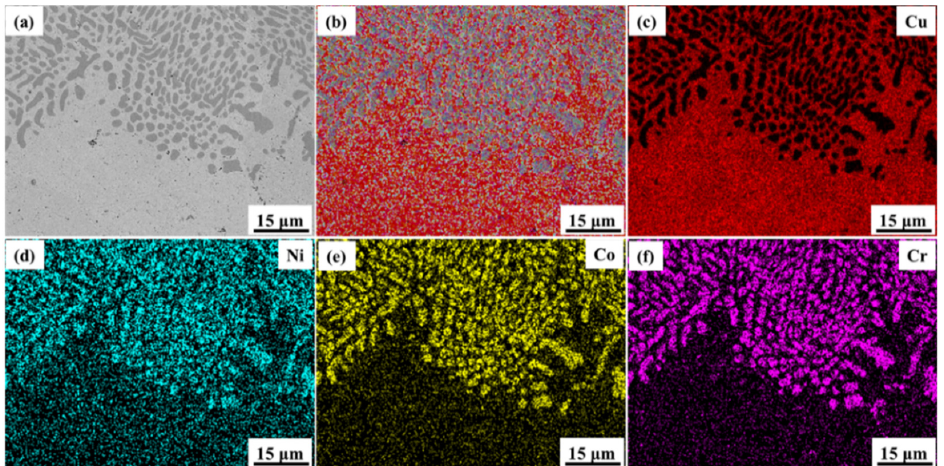
Figure 7. Interfacial morphology and elemental distributions at the interface of the Cu substrate and Cu35Ni25Co25Cr15 HEA coating deposited under a welding current of 150 A: ( a ) interfacial morphology; ( b ) distribution of all elements; ( c – f ) distributions of Cu, Ni, Co, and Cr elements, respectively.